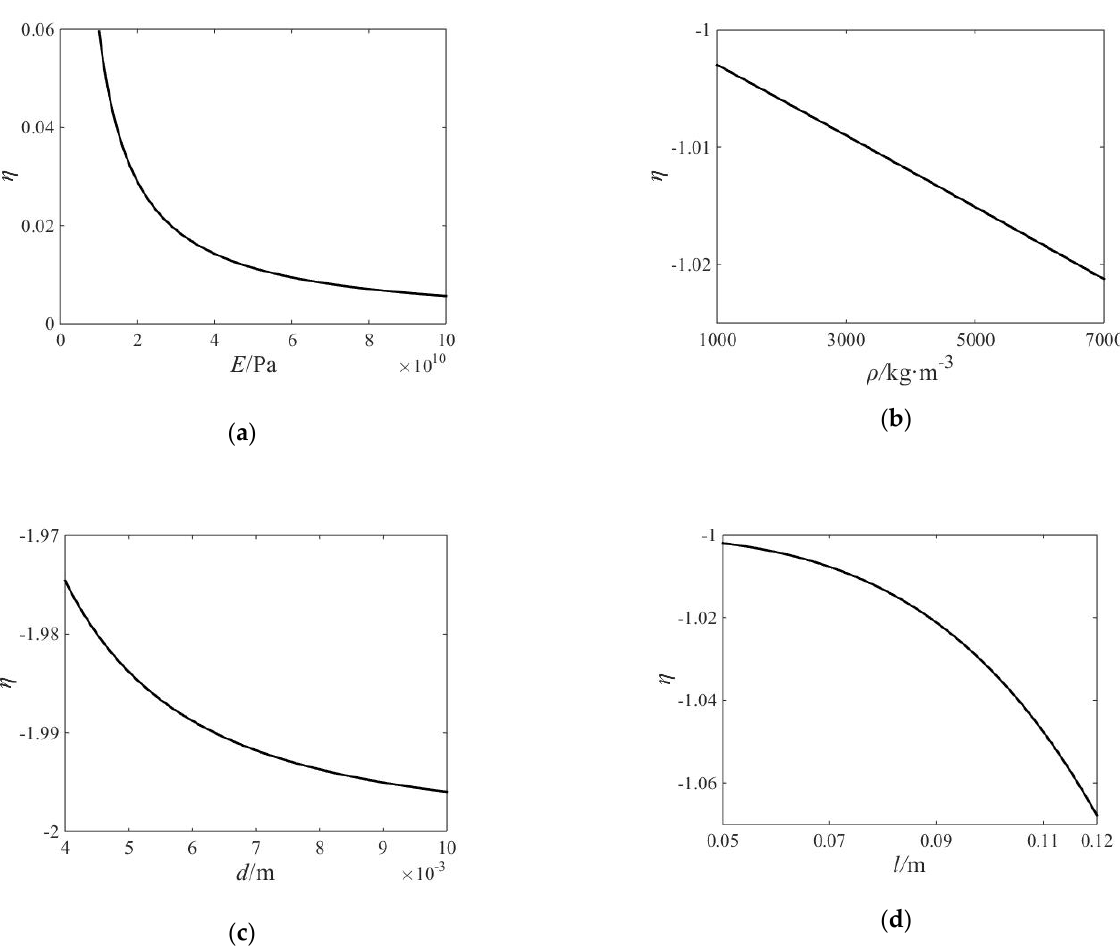
Figure 4. The relative sensitivity of the objective function: ( a ) sensitivity of elastic modulus E ; ( b ) sensitivity of density ρ ; ( c ) sensitivity of diameter d ; ( d ) sensitivity of length l.